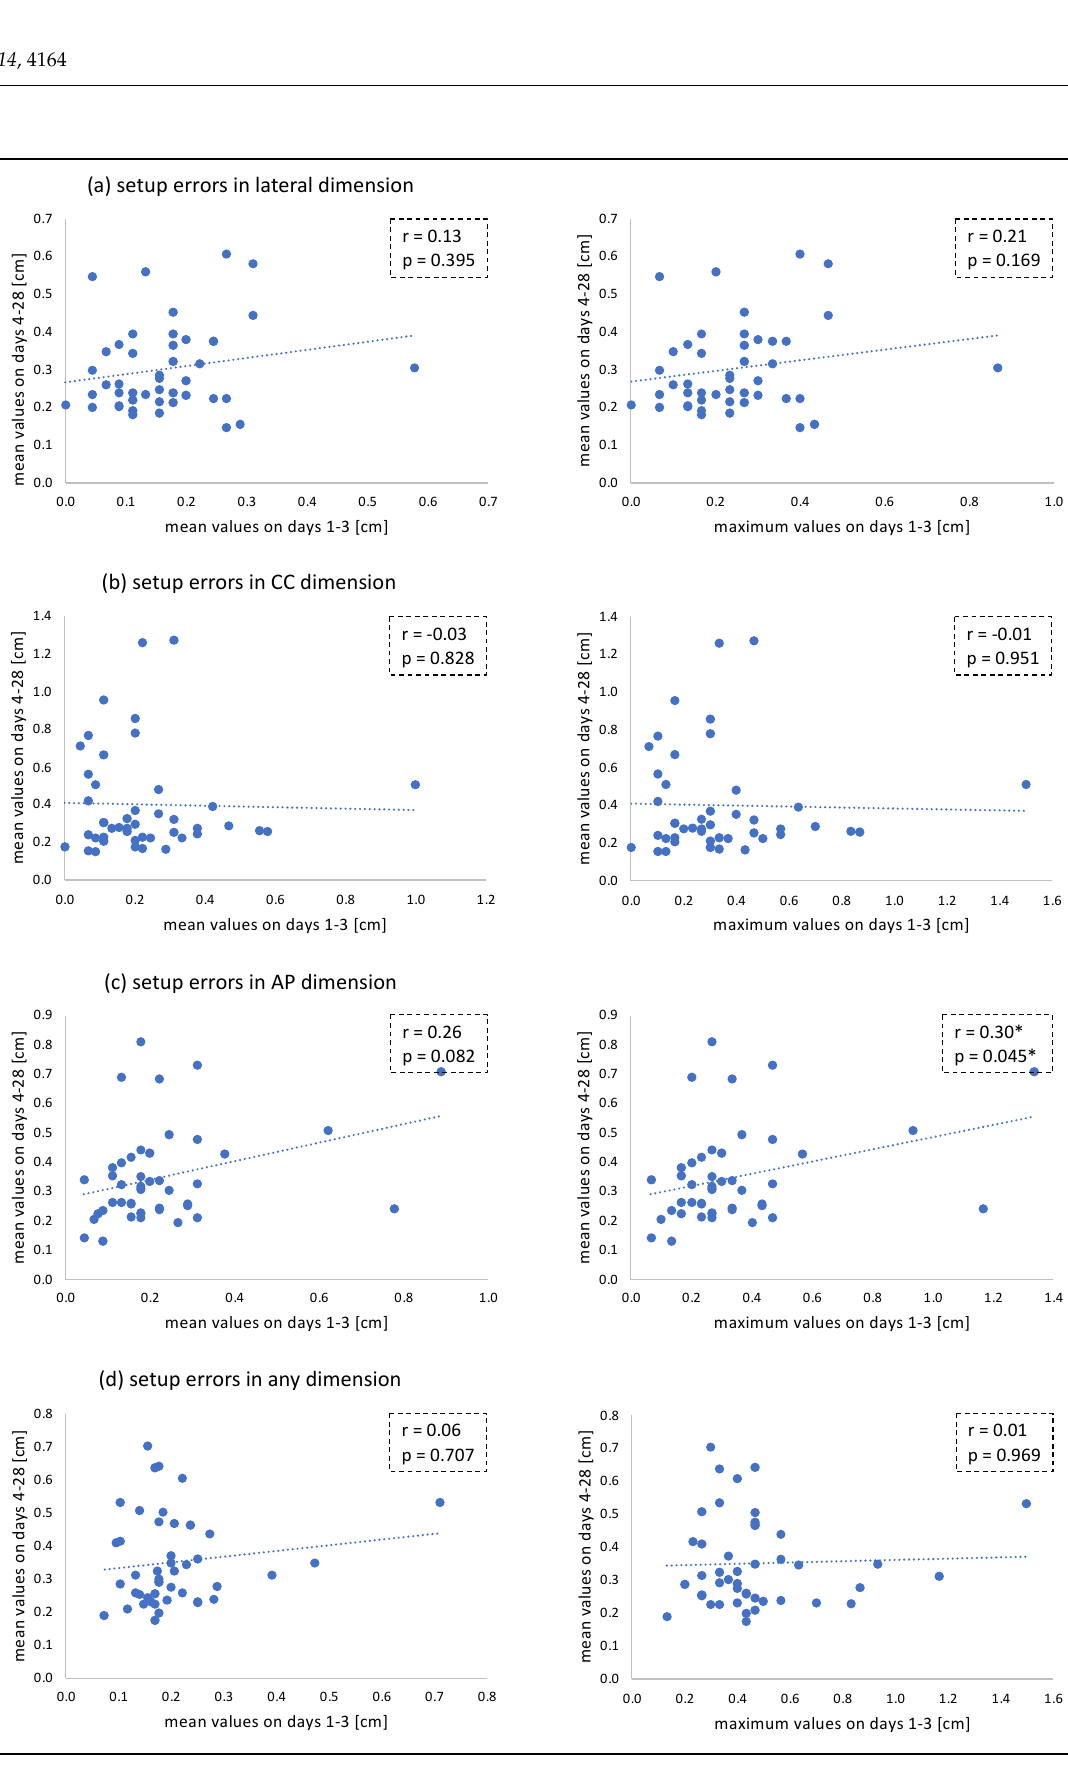
Figure 3. Relation between (mean and maximum) setup errors on days 1–3 and mean setup errors on days 4–28 in lateral ( a ), CC ( b ), AP ( c ) and any ( d ) dimension. *statistically significant ( p < 0.05).